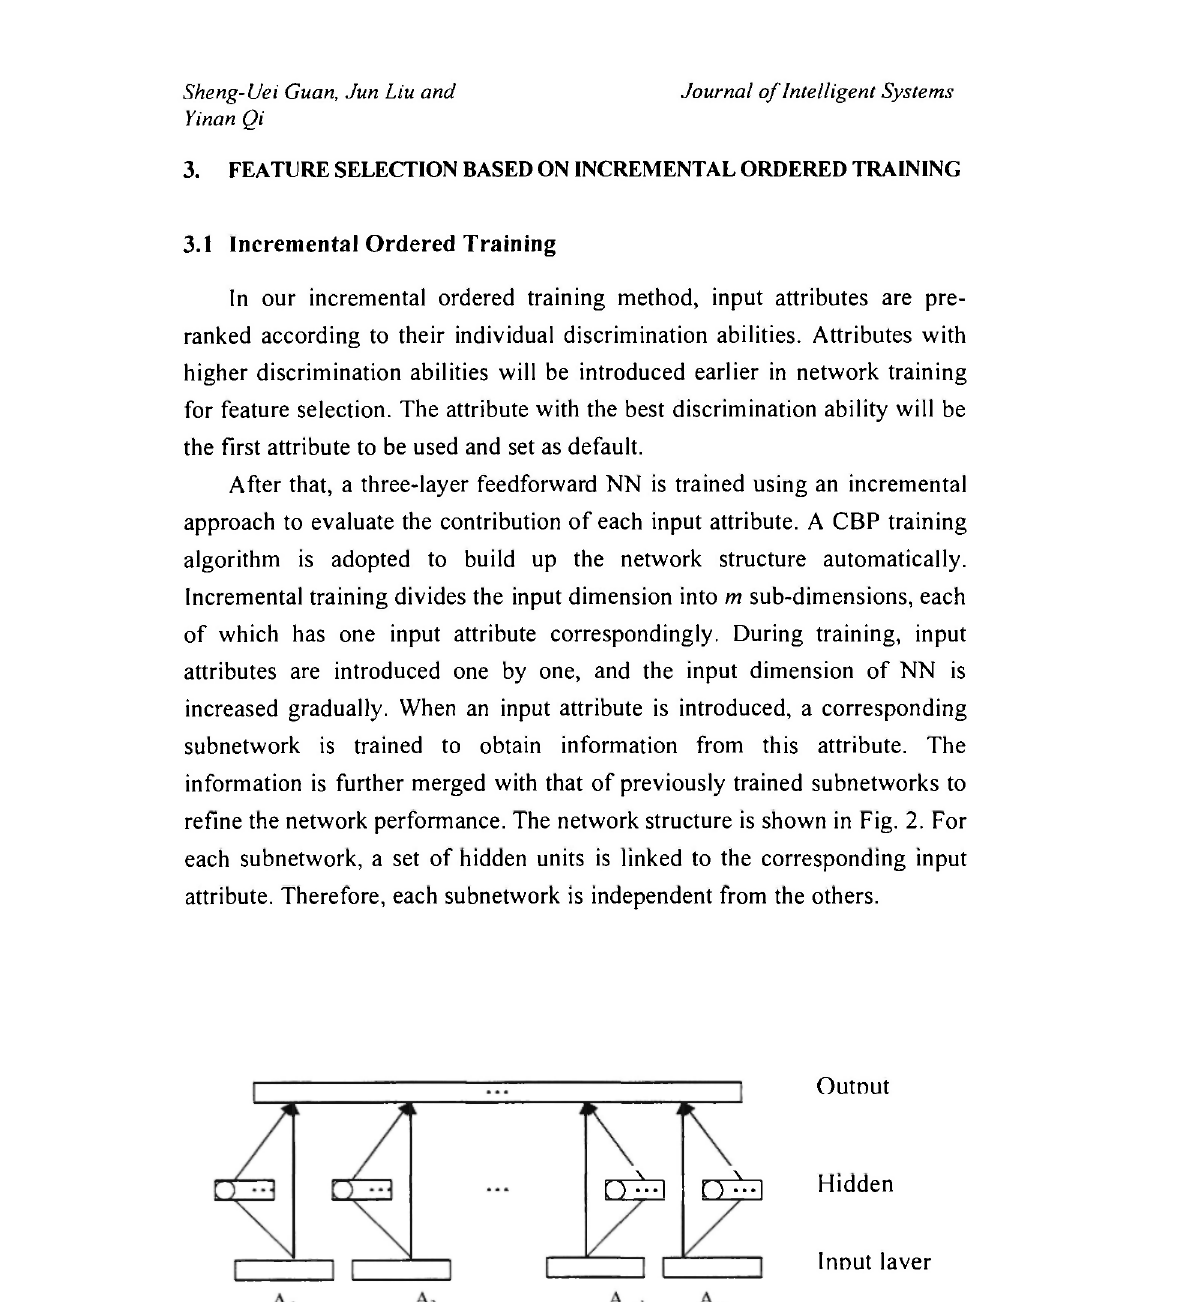
Fig. 2: Network structure of incremental training. "AT stands for an input attribute.